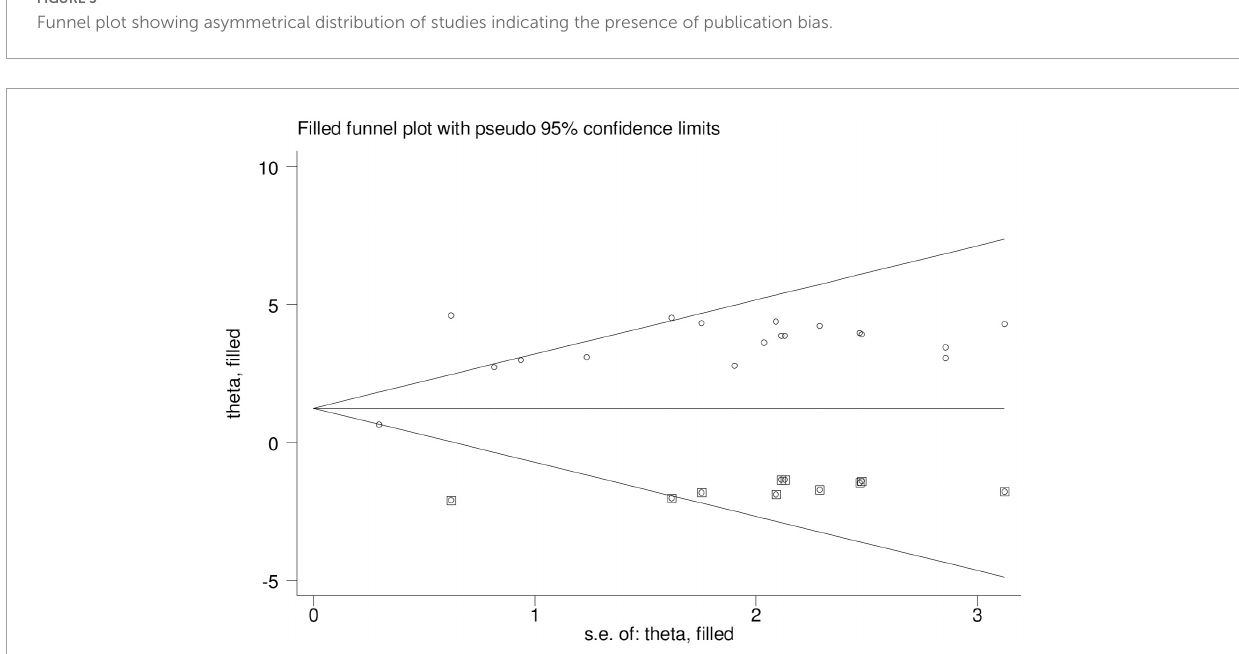
FIGURE6 Trim and fill methods of analysis displaying the presence of eight missing studies causing for funnel plot asymmetry.